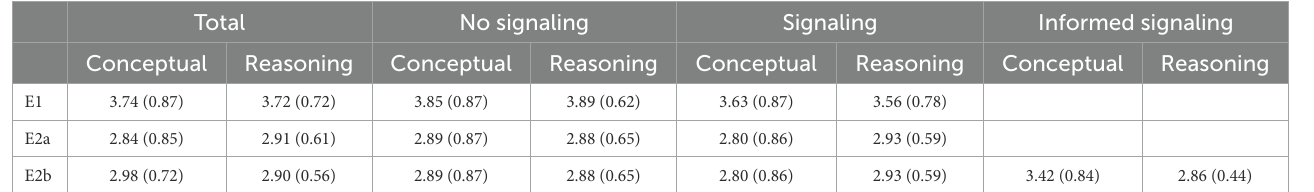
TABLE 3 Means (standard deviations) of conceptual knowledge (range: 1–5) and reasoning (range: 1–5) in all studies in total and separately for the signaling conditions. Total No signaling